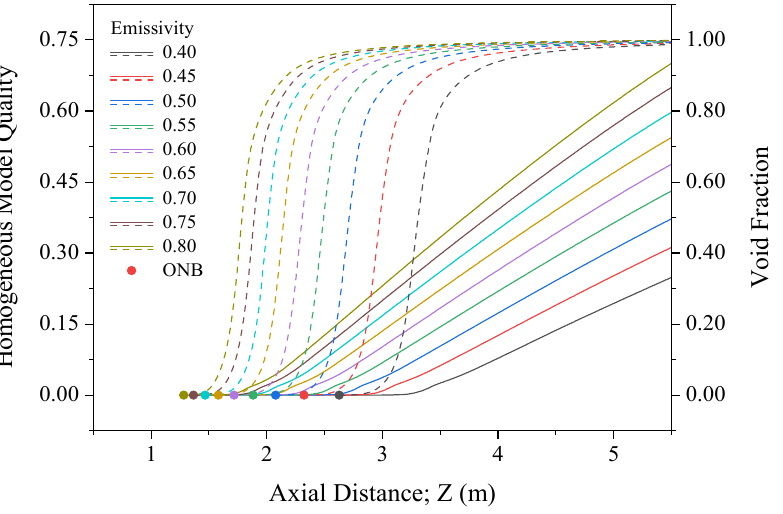
Figure 10. Homogeneous model quality distribution along the axial direction under wall emissivity from 0.40 to 0.80 (Dashed lines are void fraction).